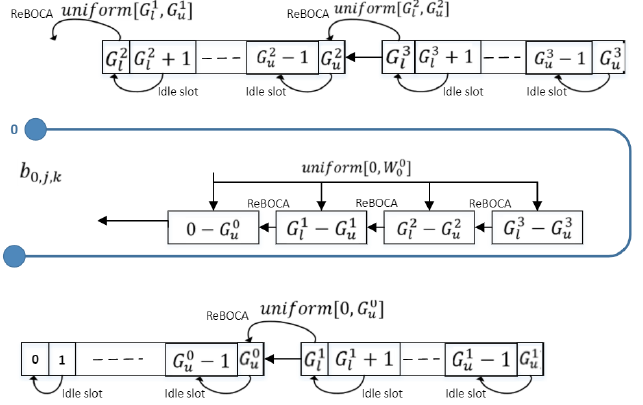
Figure 3. Transition diagram of backoff time decrements in